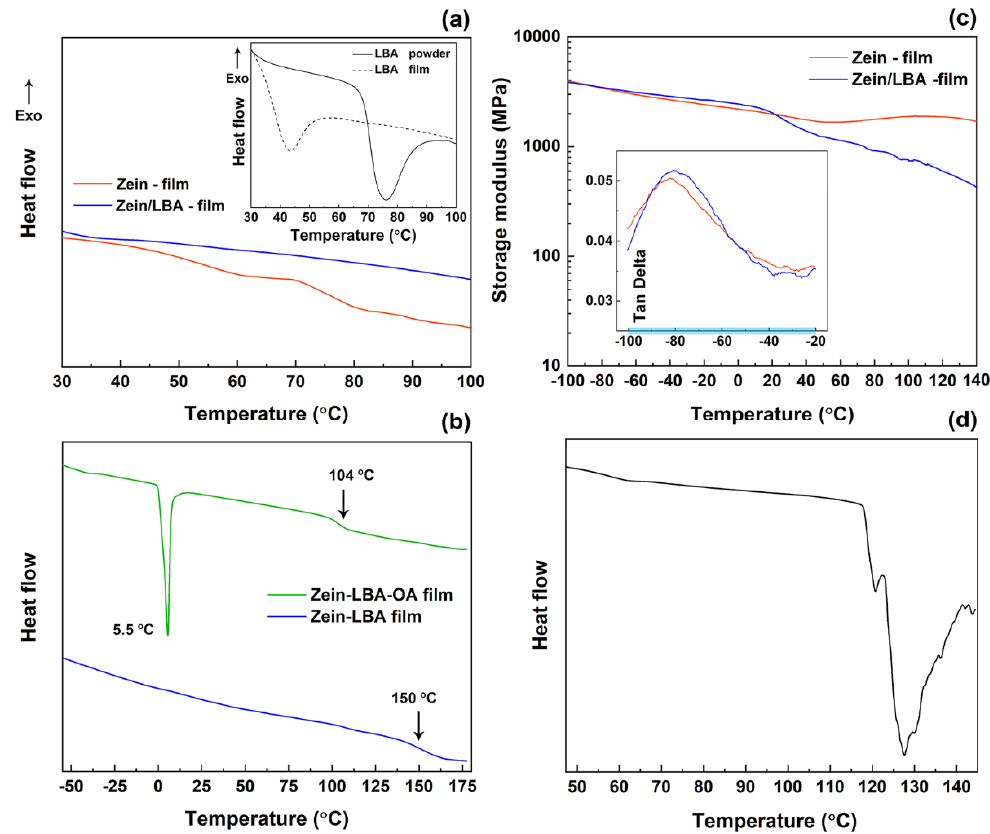
Figure 1. Differential scanning calorimetry (DSC) thermal data and dynamic mechanical analysis (DMA) spectra. ( a ) Ther- mograms of zein and zein-LBA (lactobionic acid) films and β relaxations thermograms of LBA with different thermal history (inset). ( b ) DSC thermograms for zein-LBA and zein-LBA-OA (oleic acid) films. ( c ) Variation of storage modulus with temperature, with tan δ variation in the β relaxation regions. ( d ) Thermogram for LBA for the entire spectrum from β relations to the glass transition.